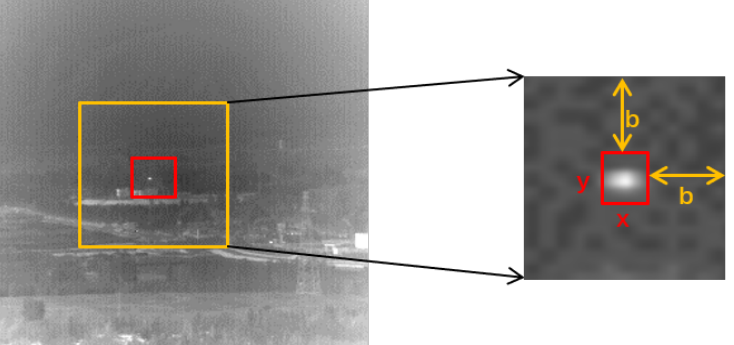
Figure 6. An introductory figure of the local background region of the target. The red box is the position of the target, and the yellow box is the local background area of the target. The size of the local background area in the figure is (x + 2b) ∗ (y +